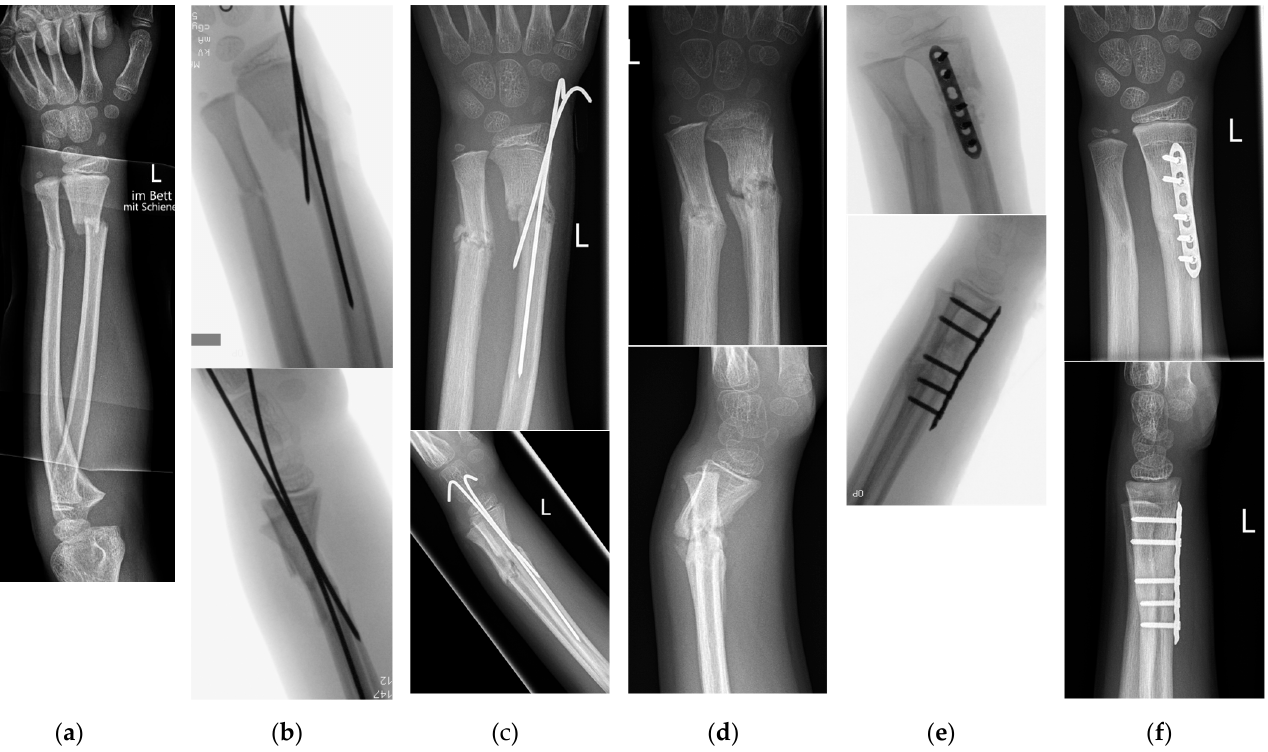
Figure 6. Boy, aged 9.5 years. He fell from a height of 1 m. ( a ) The image shows a completely dis- placed diametaphyseal fracture of the radius and a greenstick fracture of the distal shaft of the ulna. ( b ) Intraoperative image intensifier images during K-wire fixation of the diametaphyseal fracture of the radius. Note that a K-wire takes an intramedullary course within the proximal fragment, thereby reducing the stability of the fixation. ( c ) X-ray images obtained after 3 weeks show incomplete consolidation of fractures. K-wires were removed subsequently, and a forearm splint was applied. ( d ) X-ray images obtained after 7 weeks show a delayed fracture union and recurrent dorsal displace- ment of the radius fracture. ( e ) Open reduction and plate fixation were carried out 8 weeks after the injury. ( f ) Five months after the injury and 3 months after plate fixation, the fracture had healed.